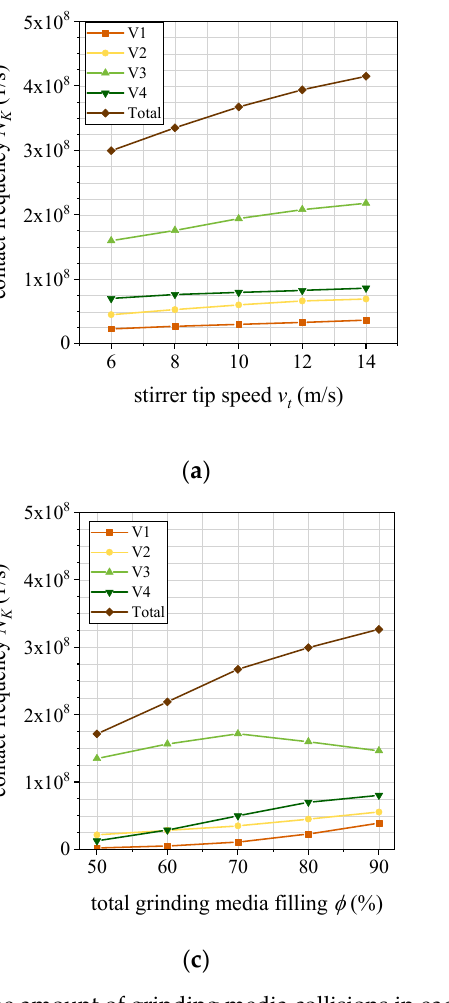
Figure 14. The amount of grinding media collisions in each volume (V1–V4): ( a ) bead–bead collision in 1 s for different stirrer speeds; ( b ) bead–bead collisions in 1 s normalized to the evaluated volume for different stirrer speeds; ( c ) bead–bead collisions in 1 s for different total grinding media fillings; ( d ) bead–bead collisions in 1 s normalized on the evaluated volume for different grinding media fillings.